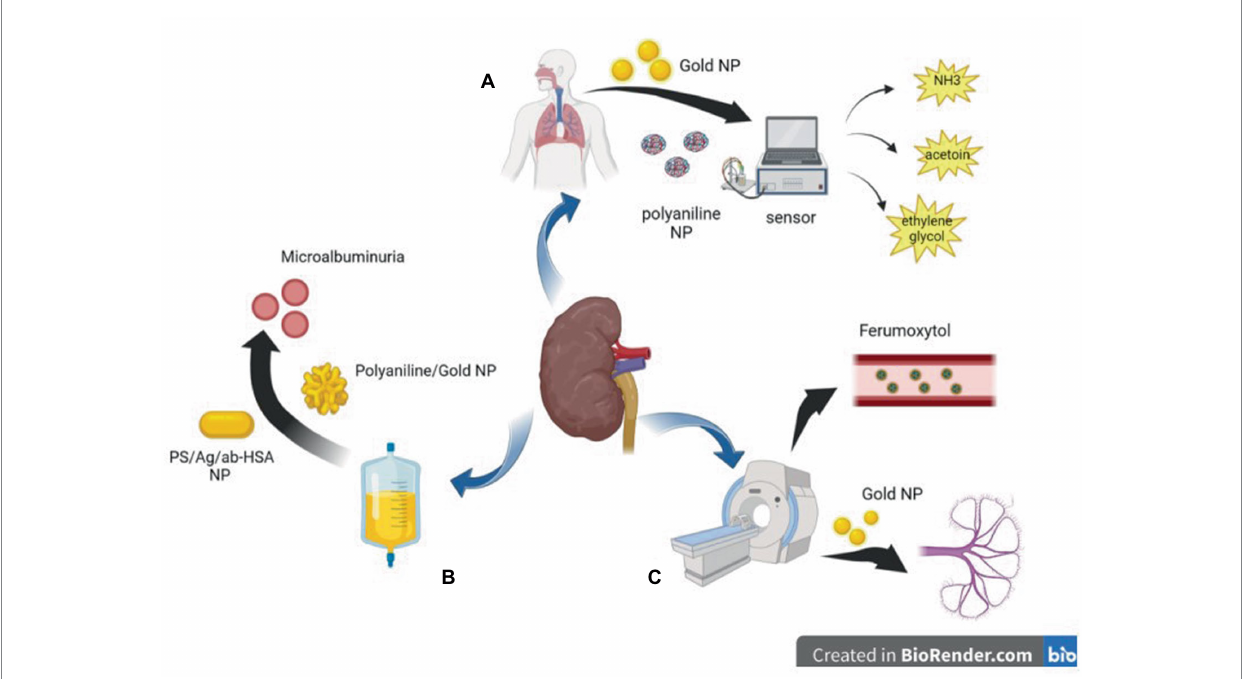
FIGURE 1 Diagram of application of nanoparticles in auxiliary inspection. (A) polyaniline nanoparticles and Gold nanoparticles based sensors can detect harmful gases in the breath of CKD patients. (B) Polyaniline nanoparticles and Gold nanoparticles based biosensor can detect trace albumin in the urine of patients with CKD at an early stage. (C) Gold nanoparticles and magnetic nanoparticles can be used in CT or MRI imaging to reduce kidney damage caused by iodine or gadolinium contrast